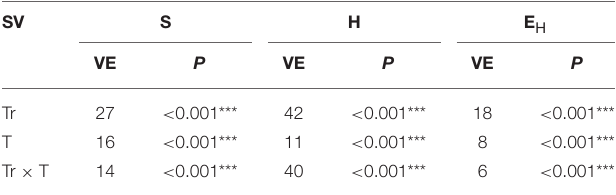
TABLE 4 | Analysis of variance (the two-way ANOVA) for the RS indices as affected by the treatment (Tr), time (T) and their interactions.